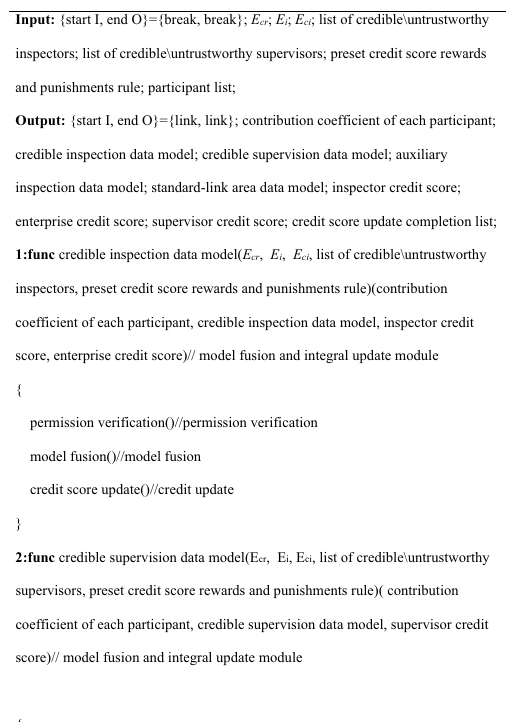
Algorithm 3: Credit-Evaluation Smart Contract